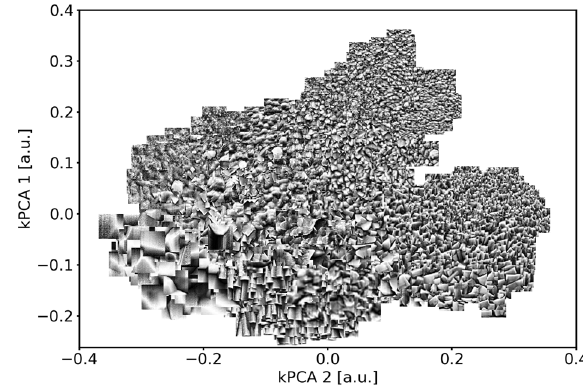
validation set. Patches created from experimental SEM surface images are plotted at their position in the dimensionally-reduced latent space. A continuous variation of microstructures is observed with respect to similarity of feature size and shape (e.g., featureless, fi ne-grained, oriented- facetted,